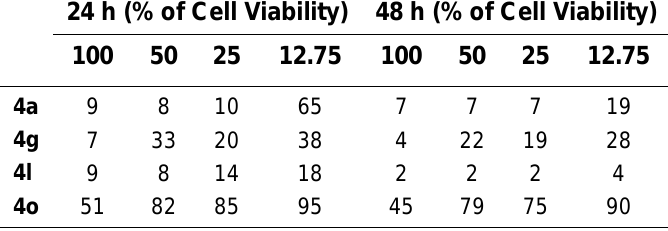
Cytotoxicity of Compounds 4a, 4g, 4l, and 4o